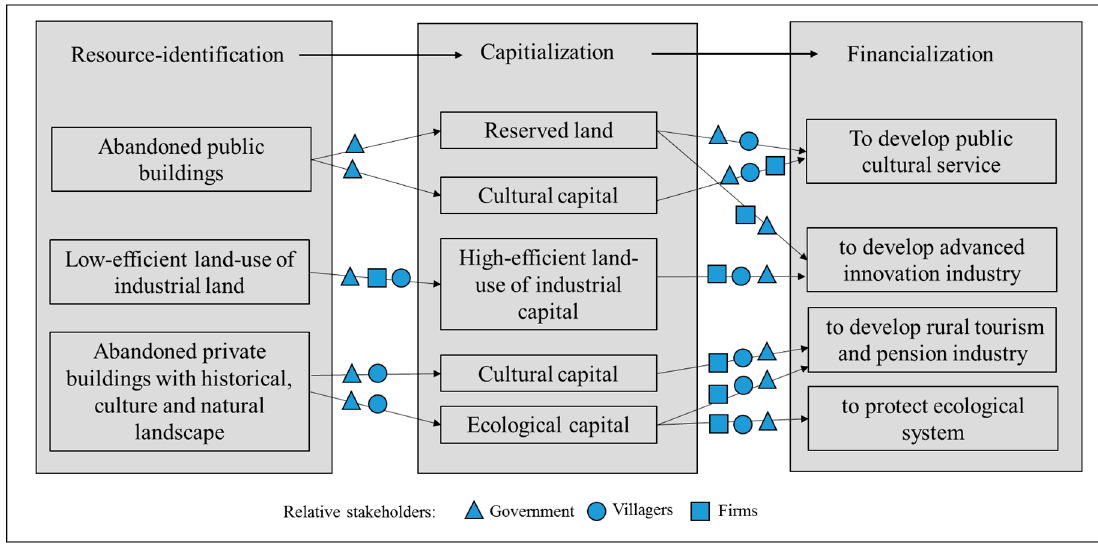
Figure 6. Stakeholders in the three rural revival phases.